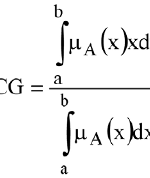
Figure 8. Clipping (min) method.